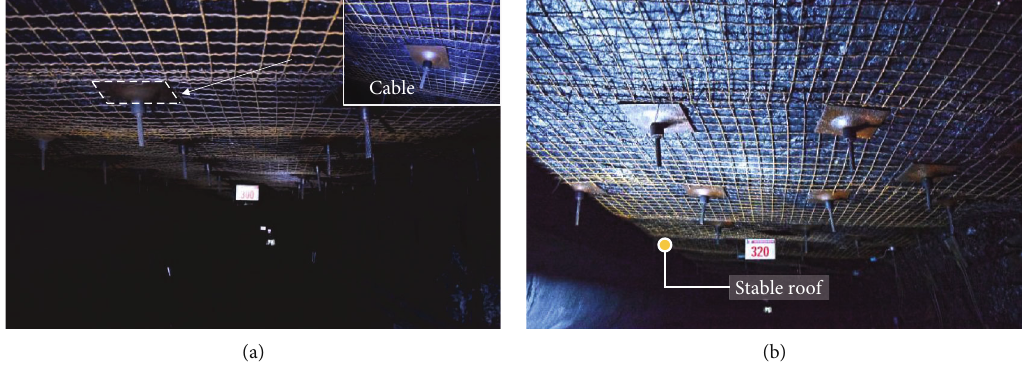
Figure 15: Real photos of the roof under TADL